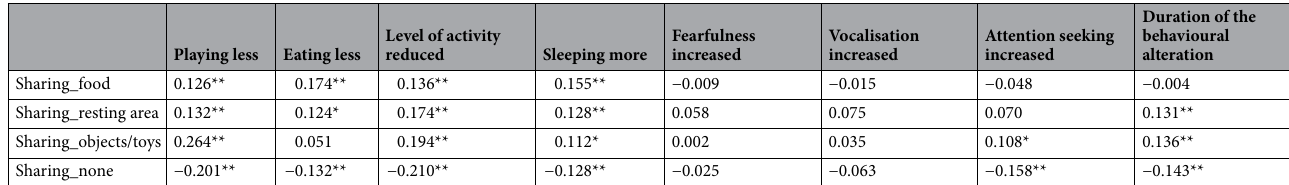
Table 3. Correlation between shared items between the two dogs and behavioural change observed in the surviving dog after the death of the other dog. * p < 0.05; ** p < 0.01; *** p < 0.001.